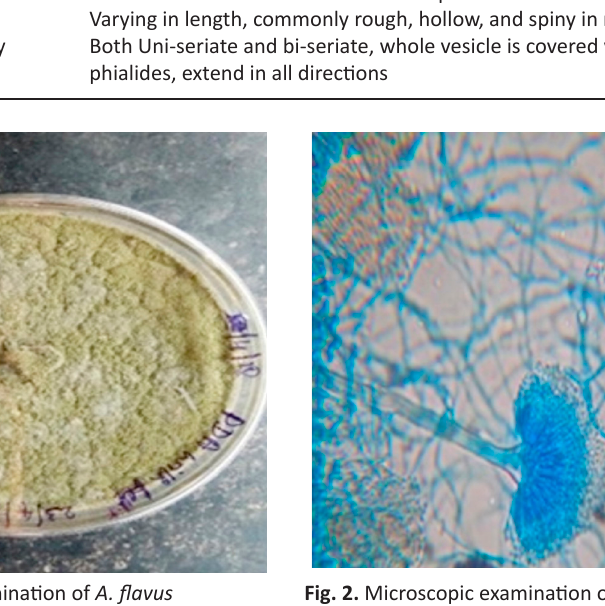
Fig. 1. Macroscopic examination of A. flavus Fig. 2. Microscopic examination of A. flavus